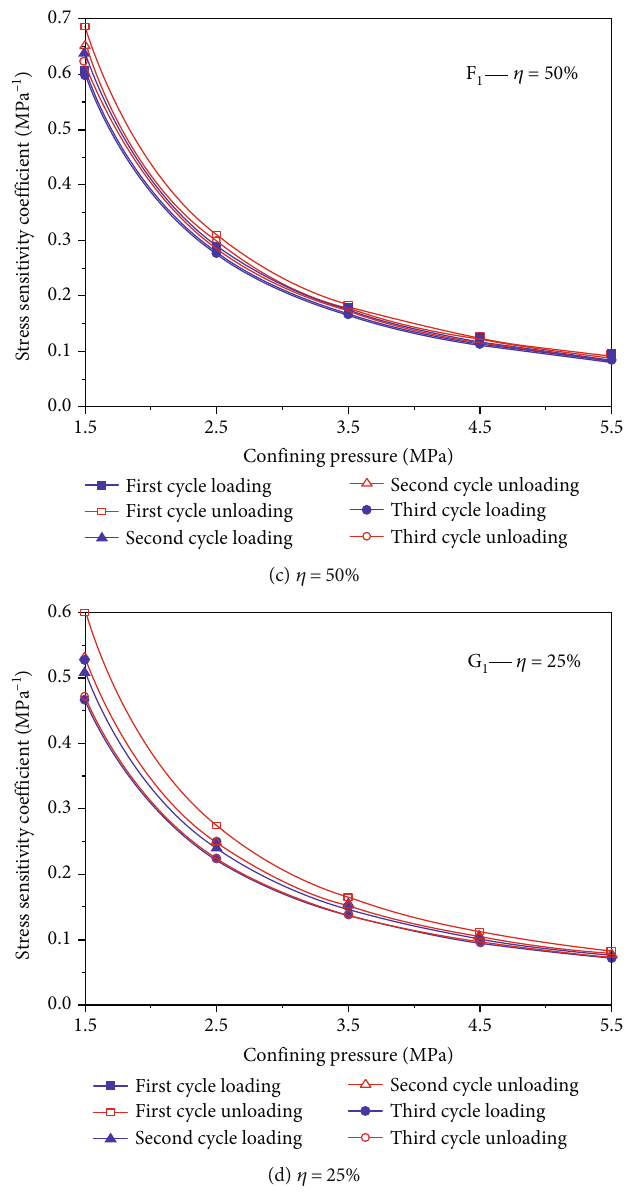
Figure 9: Variation curves of stress sensitivity coe ffi cients and con fi ning